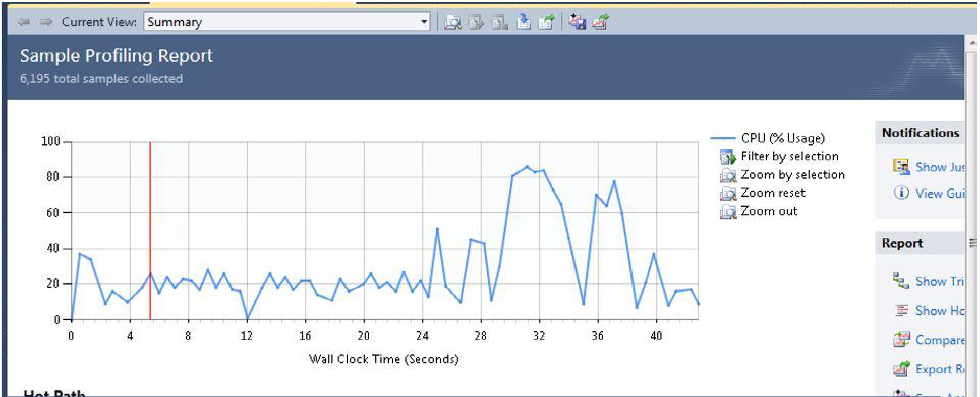
Figure 10. CPU-level analysis of two execution scenarios.